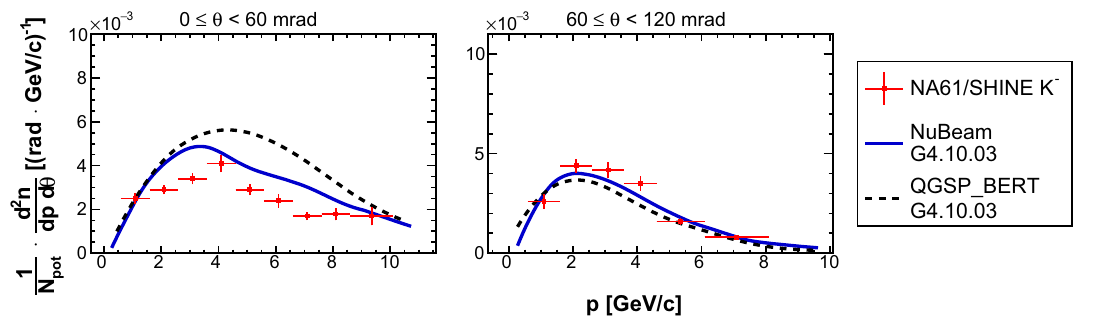
QGSP_BERT (dashed black line) physics lists from Geant4.10 .03 [27,28] are overlaid on top of the